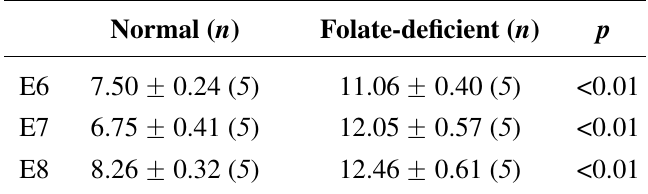
Table 3. Serum Hcy levels ( µ mol/L) in the pregnant mice (mean ˘ standard error of the mean